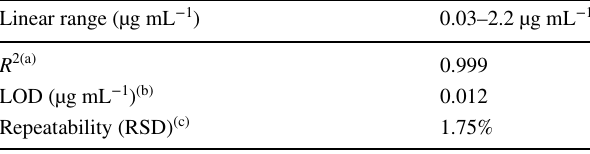
Table 5 Analytical characteristics of the proposed